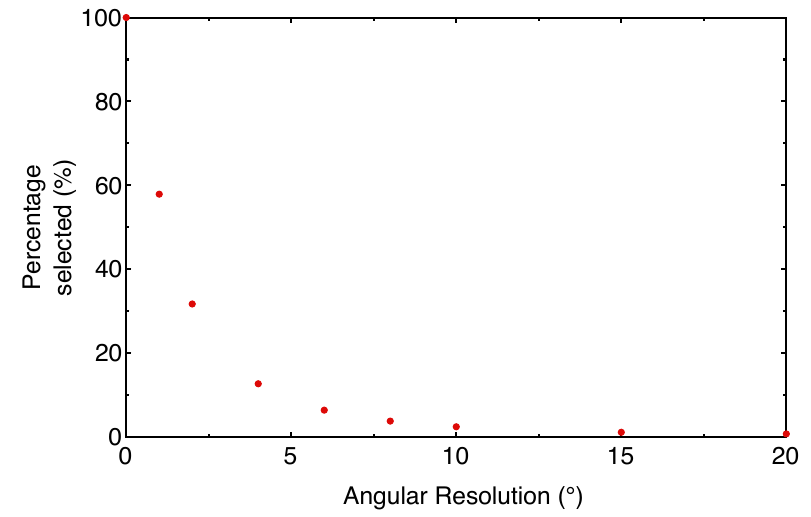
Figure 5. The selectivity of the filtering algorithm for increasing angular resolution. As can be seen, the percentage of retained data falls off sharply with coarser angular